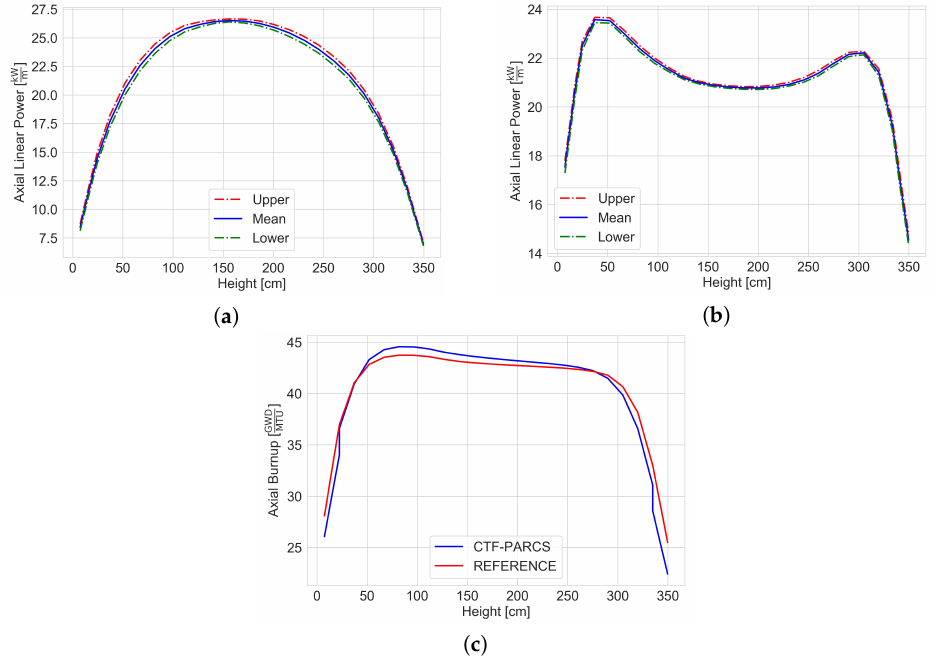
( b ) P ave and ( c ) Bu ave compared with the bench- ax,EOC lin,BOC lin,EOC